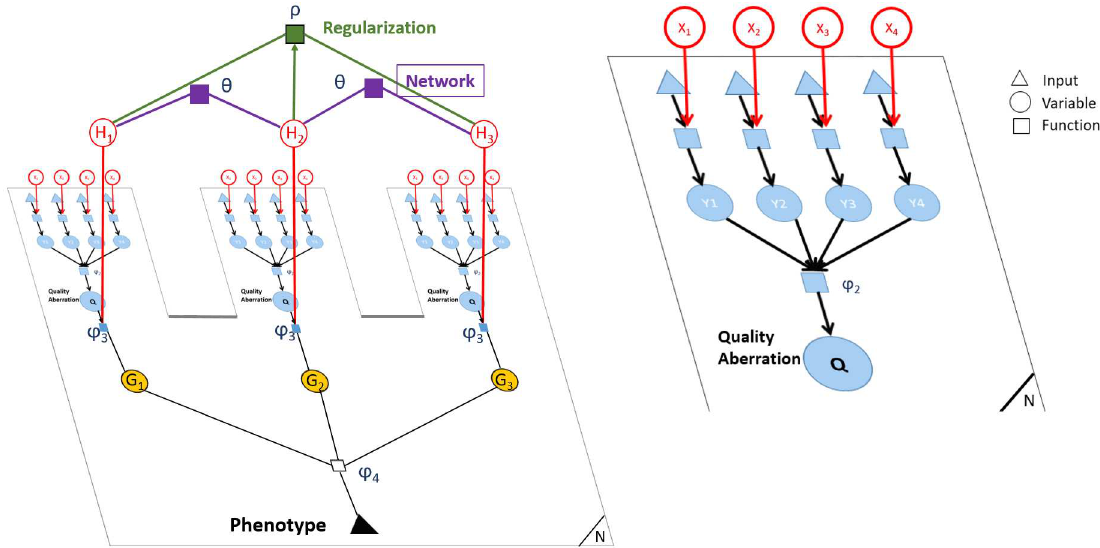
Fig 6. Conflux’s hierarchical graphical model. Graphicalmodel representing the relationbetweenphenotypes, coding variants and gene latent variableswith the PPI network used as prior. All the variables, factors and inputs insidethe plate are per individual.The variables, factors and inputs outside the plate, such as protein-protein interactionsare not individual-specific. This model simultaneously uses all genes genome-wide and is shown here for 3 genes for clarity. The graph on the right is a zoom in on the gene specific portion of the